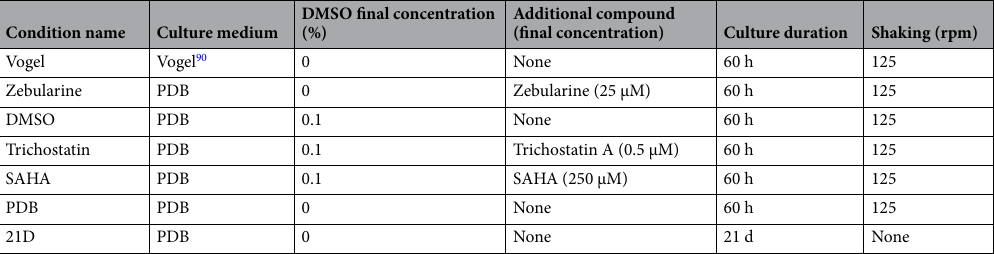
Table 2. A. dauci FRA001 strain liquid culture growth